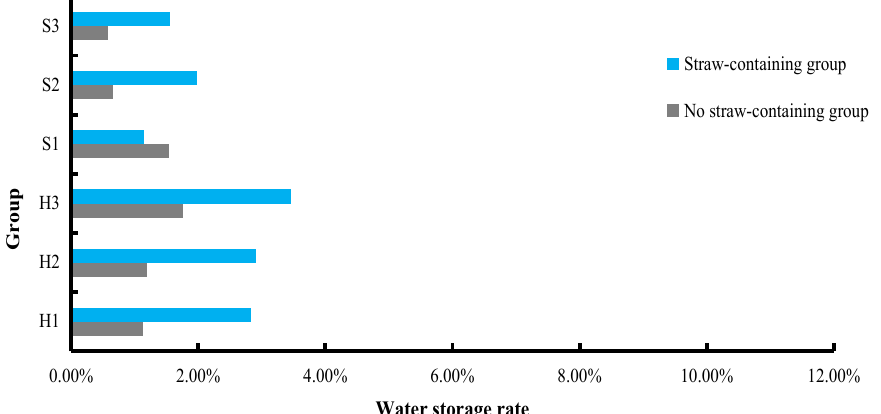
Figure 5. Comparison of water storage rate of specimens after 24 h immersion.